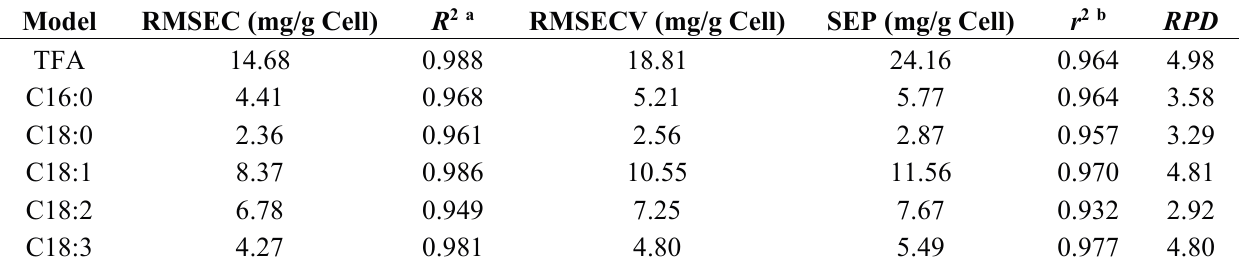
a R 2 : multiple coefficient of determination of calibration models; b r 2 : coefficient of determination of regression models tested with validation